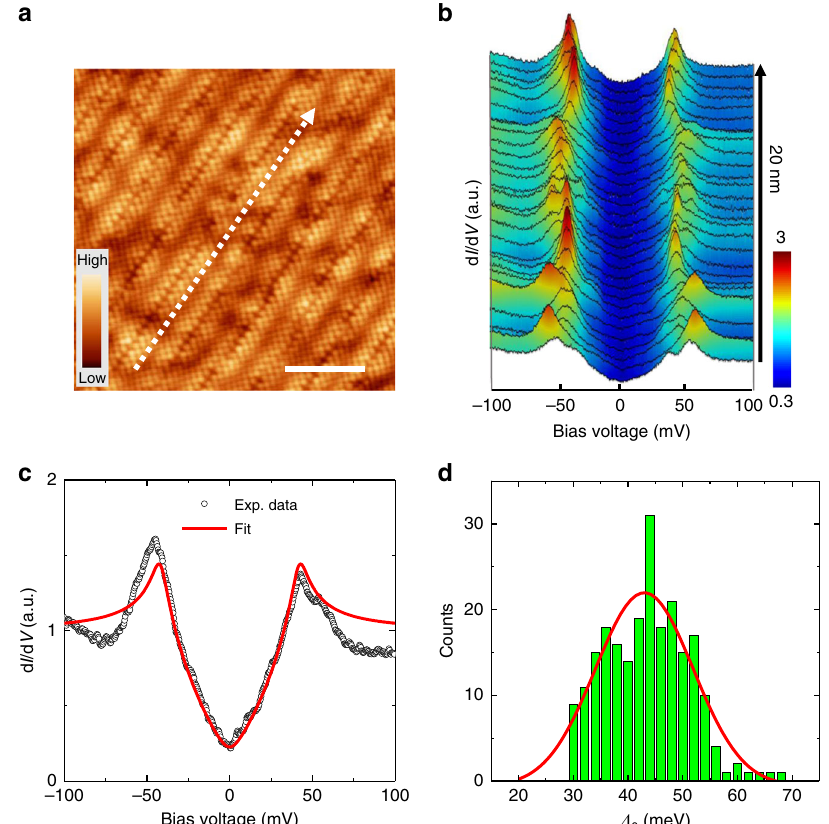
Fig. 1 Topographic image and tunneling spectra measured on optimally doped Bi-2212. a A typical topographic image of the BiO surface after cleavage measured at bias voltage V bias = 50 mV and tunneling current I t = 100 pA. Scale bar, 5 nm. b Tunneling spectra measured along the arrowed line in a . The set-point conditions are V set = 100 mV and I set = 100 pA for measuring all the spectra in b . c A typical spectrum (open circles) selected from b . The solid line shows the Dynes model fi tting result with a d -wave superconducting gap. d The statistics of superconducting gap maxima Δ 0 for about 200 tunneling spectra measured on the Bi-2212 samples, and the gap maximum values are determined from the positions of the coherence-peaks. The red curve is a Gaussian fi tting result with the peak position near 43